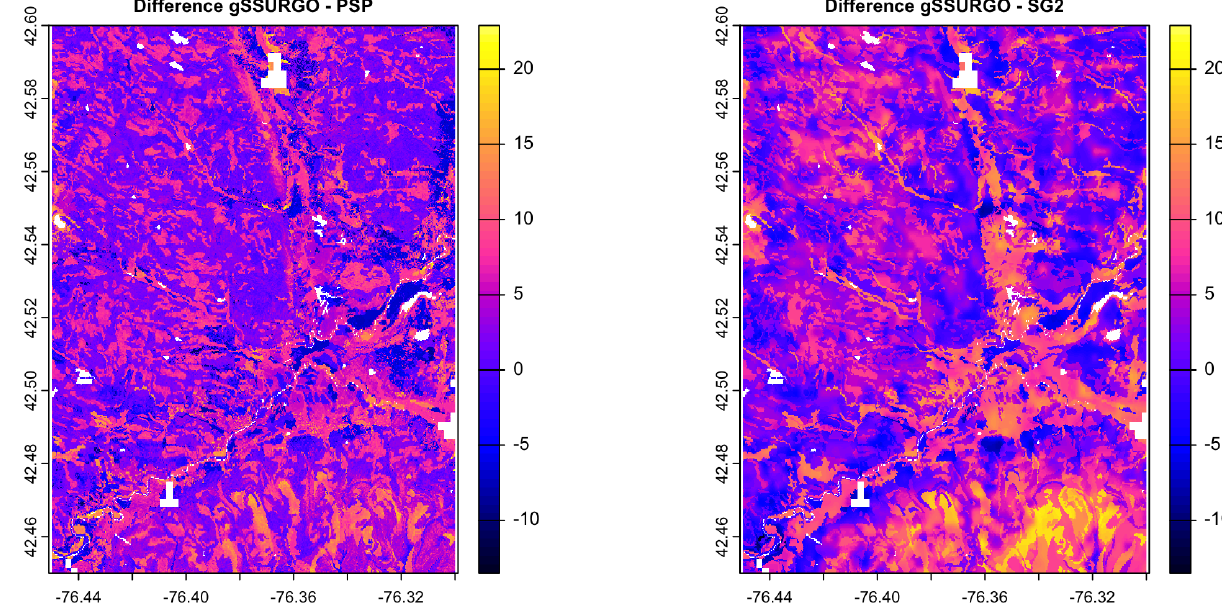
Figure 22. The difference between gSSURGO and DSM products for pH × 10 at 0–5cm. See the text for a